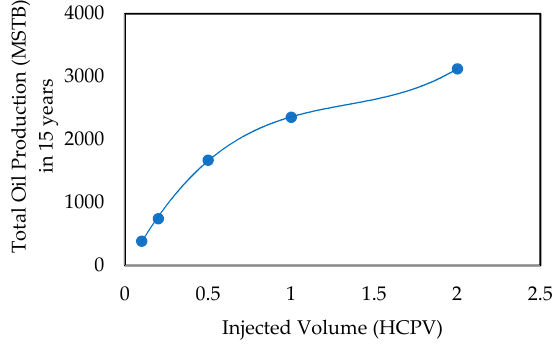
Figure 14. Variation of oil production with injected flood volume (HCPV) in WAG process.